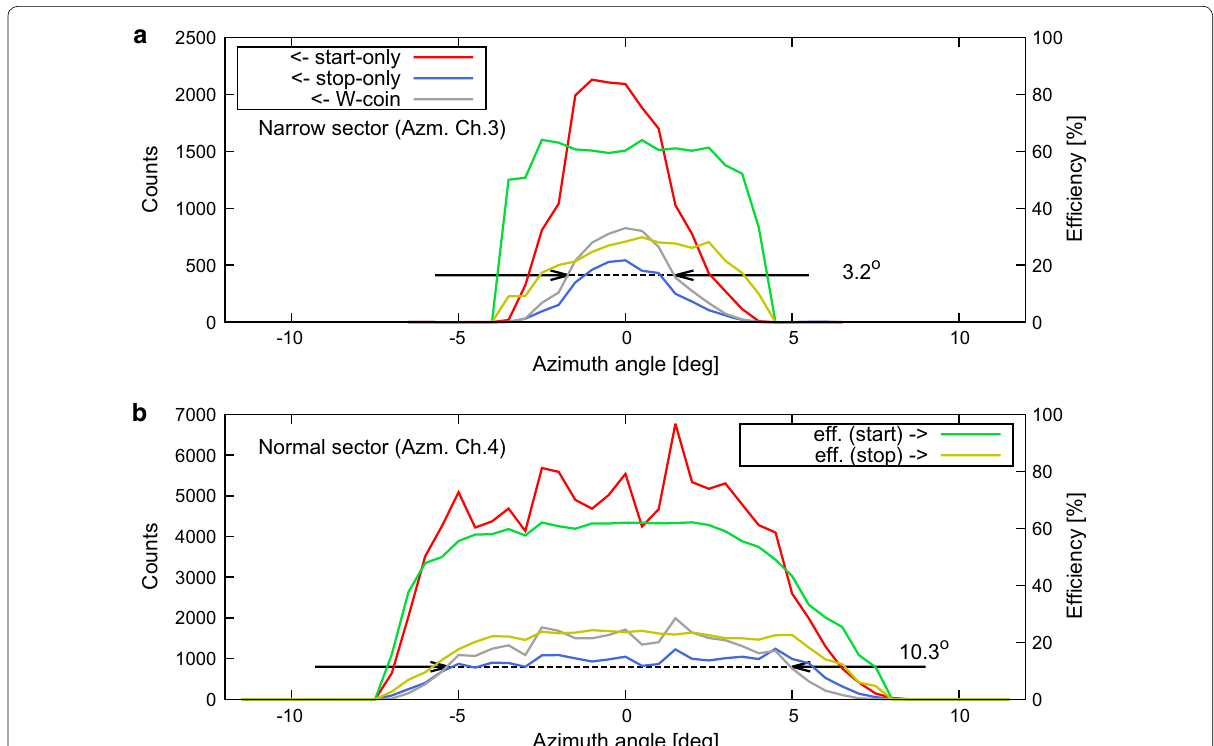
Fig. 8 Dependences of count rates and efficiencies on the incident azimuthal angle for the a narrow and b normal